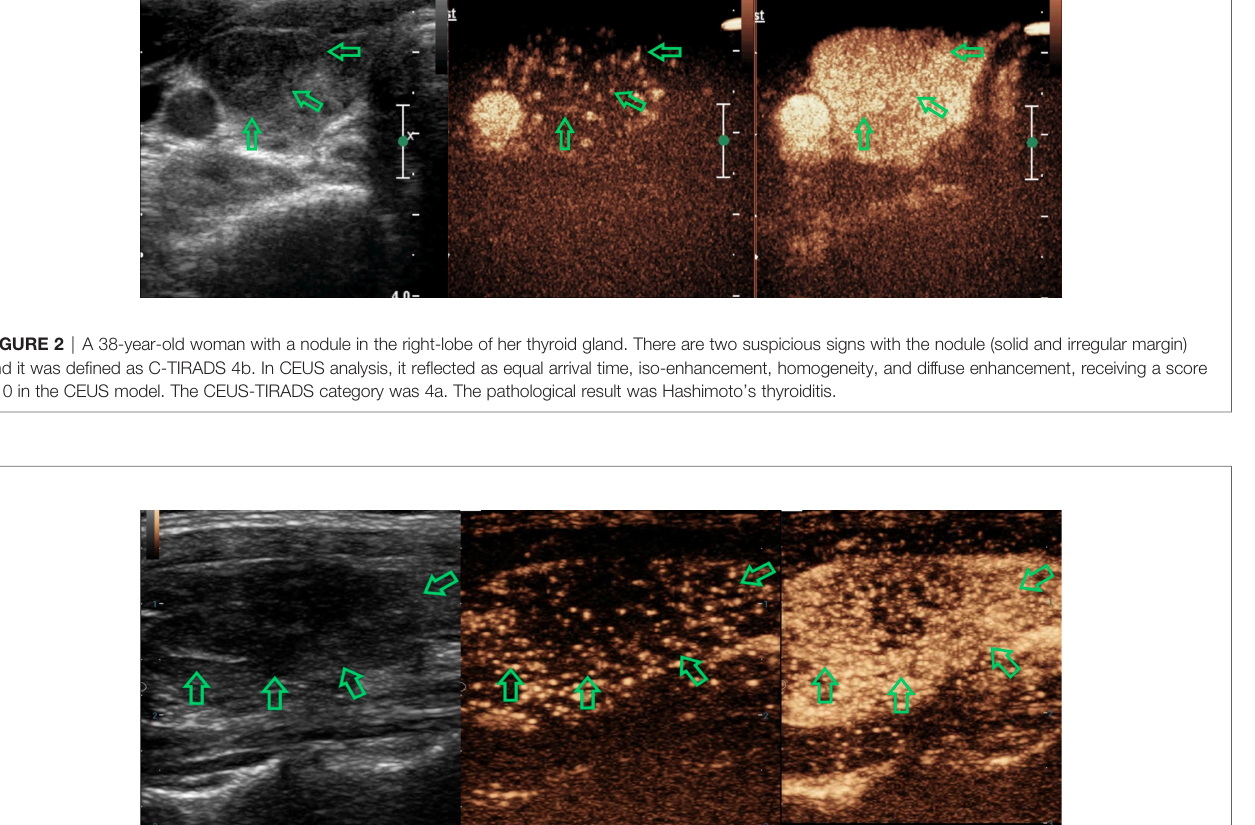
FIGURE 3 | A 35-year-old woman with a nodule in the left-lobe of her thyroid gland. There are two suspicious signs with the nodule (solid and irregular margin) and it was de fi ned as C-TIRADS 4b. In CEUS analysis, it re fl ected as later arrival time, hypo-enhancement, heterogeneous and centripetal enhancement, getting a score of 4 in the CEUS model. The CEUS-TIRADS category was 4c. The pathological result was papillary thyroid carcinoma.